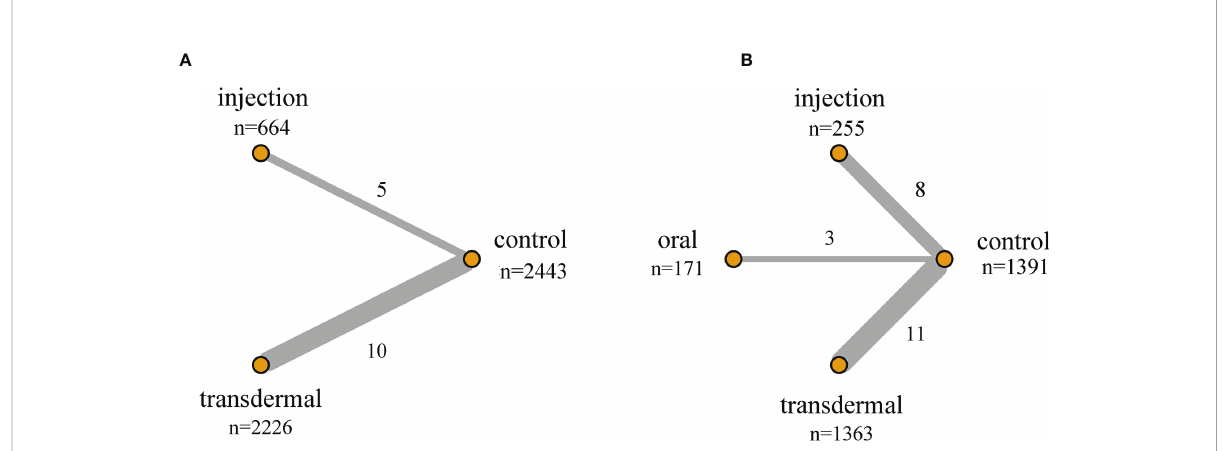
FIGURE 2 Network structure of the comparisons of primary outcomes for the Bayesian network meta-analysis. (A) Pca Cases; (B) PSA Level Changes. The size of the circles represents the sample size of each arm (in parentheses), and the thickness of the line represents the number of head-to-head studies (beside the